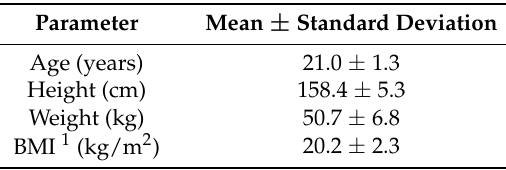
Table 1. Participant characteristics (N =